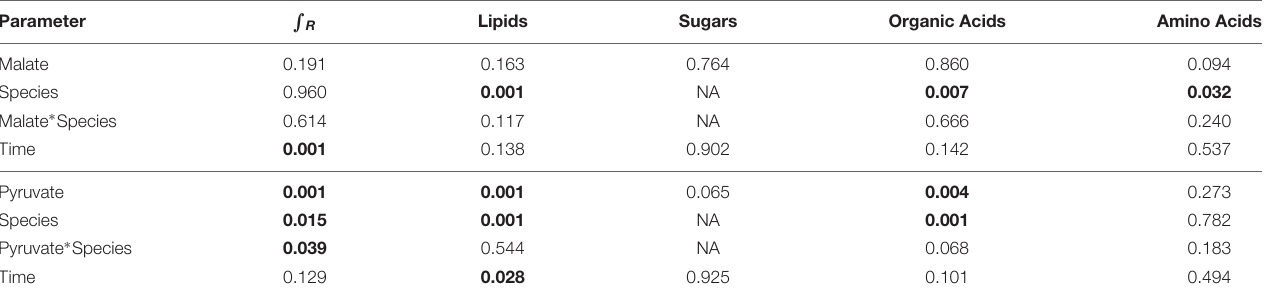
TABLE 2 | Statistical analyses of (cid:82) R and (cid:49) Label values from different metabolic fractions. Parameter (cid:82) R Lipids Sugars Organic Acids Amino